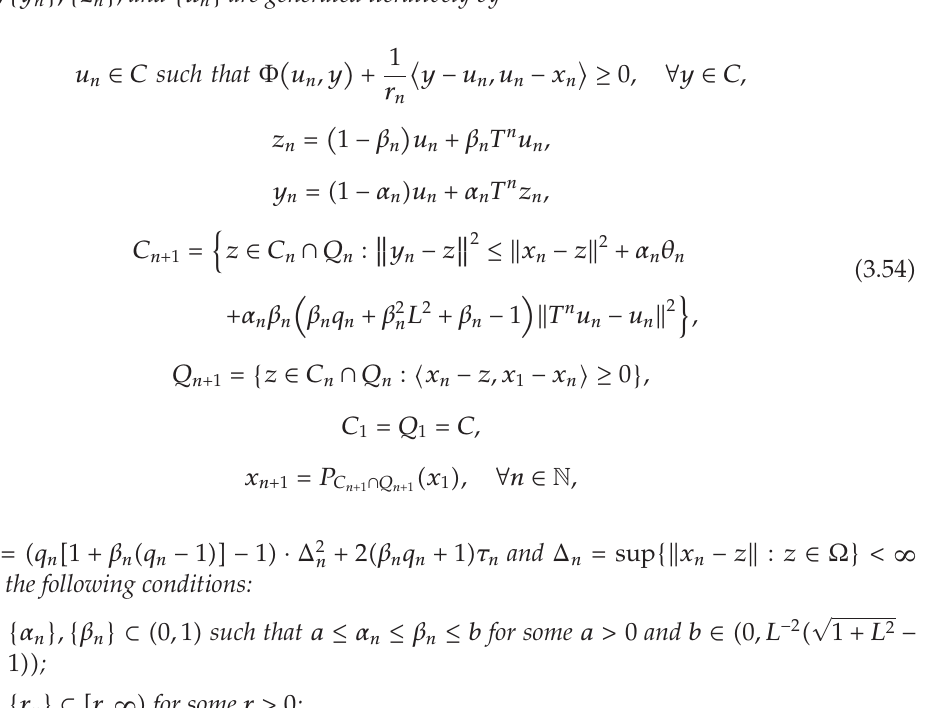
pseudocontractive mapping in the intermediate sense and the set of solutions of the mixed equilibrium problems by iteration is